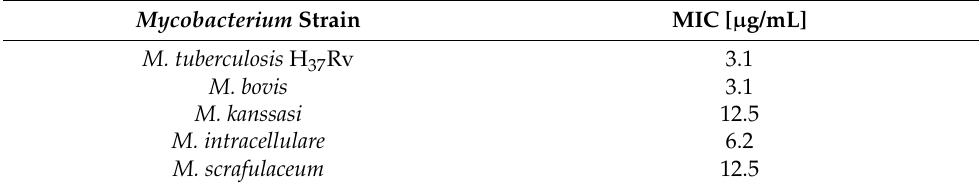
Table 3. In vitro activity of compound 1b towards various Mycobacterium